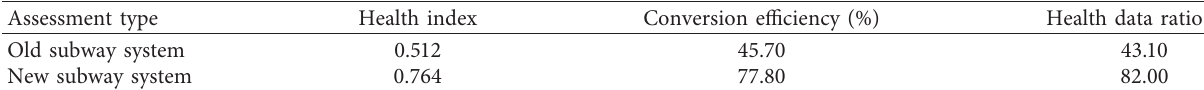
Table 1: The health assessment